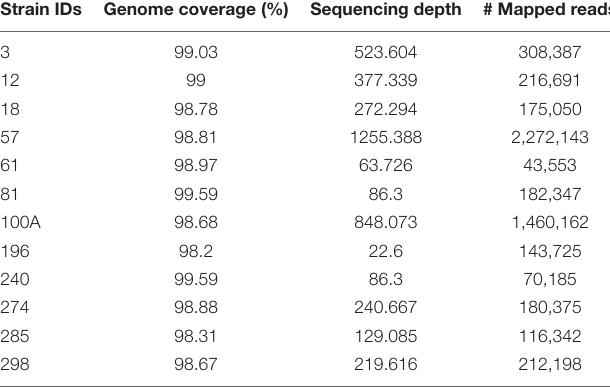
TABLE 1 | Read and assembly